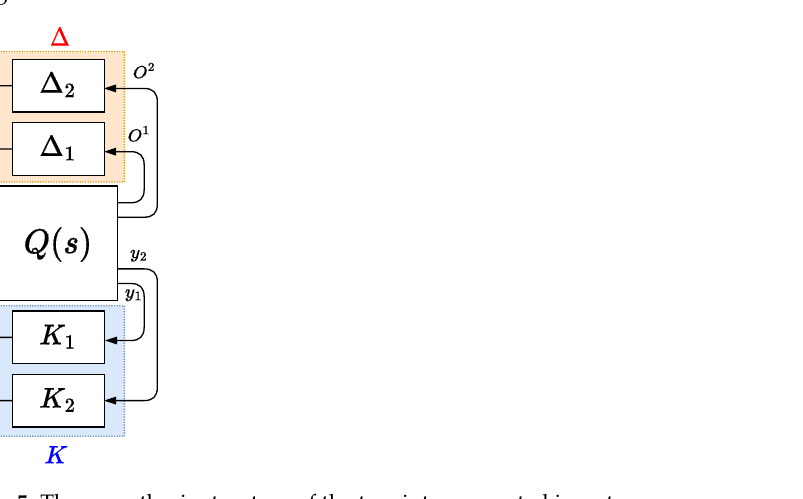
Figure 5. The µ -synthesis structure of the two interconnected